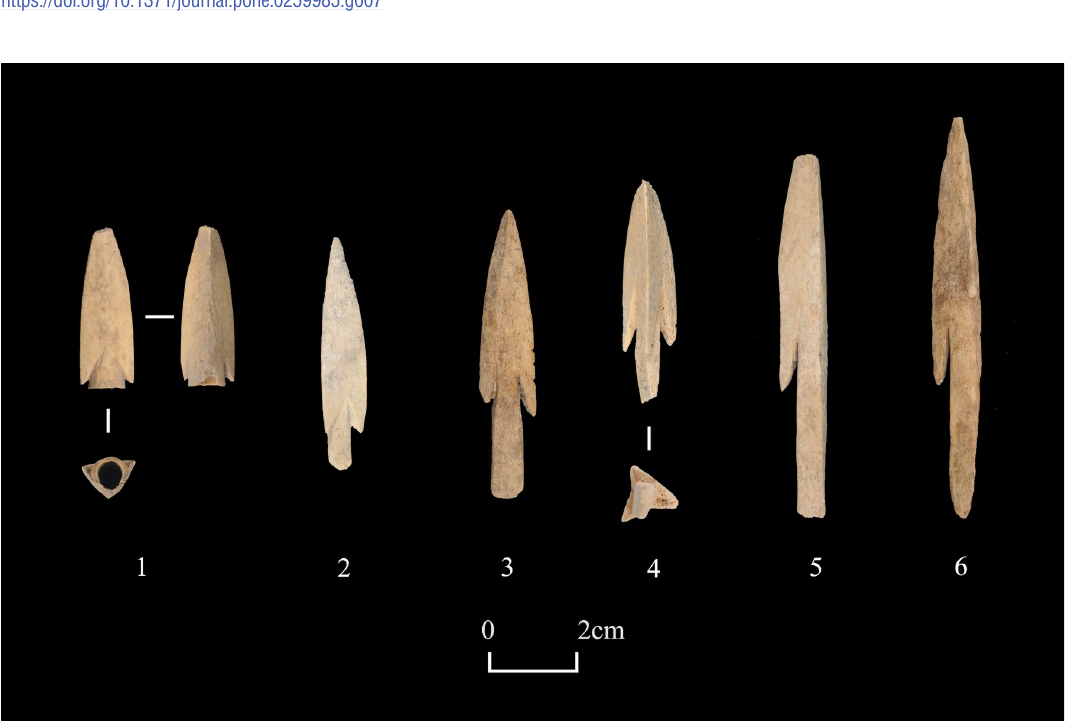
Fig 8. Examples of bone arrowheads from Shirenzigou. 1) specimen from 2009HBSIIIT0719 ③ ; 2) specimen from 2010HBSIIIM003 ④ ; 3) specimen from 2007BSDIVM013; 4) specimen from 2010HBSIIIM003 ⑤ ; 5) specimen from 2010HBSIIIM003 ④ ; 6) specimen from